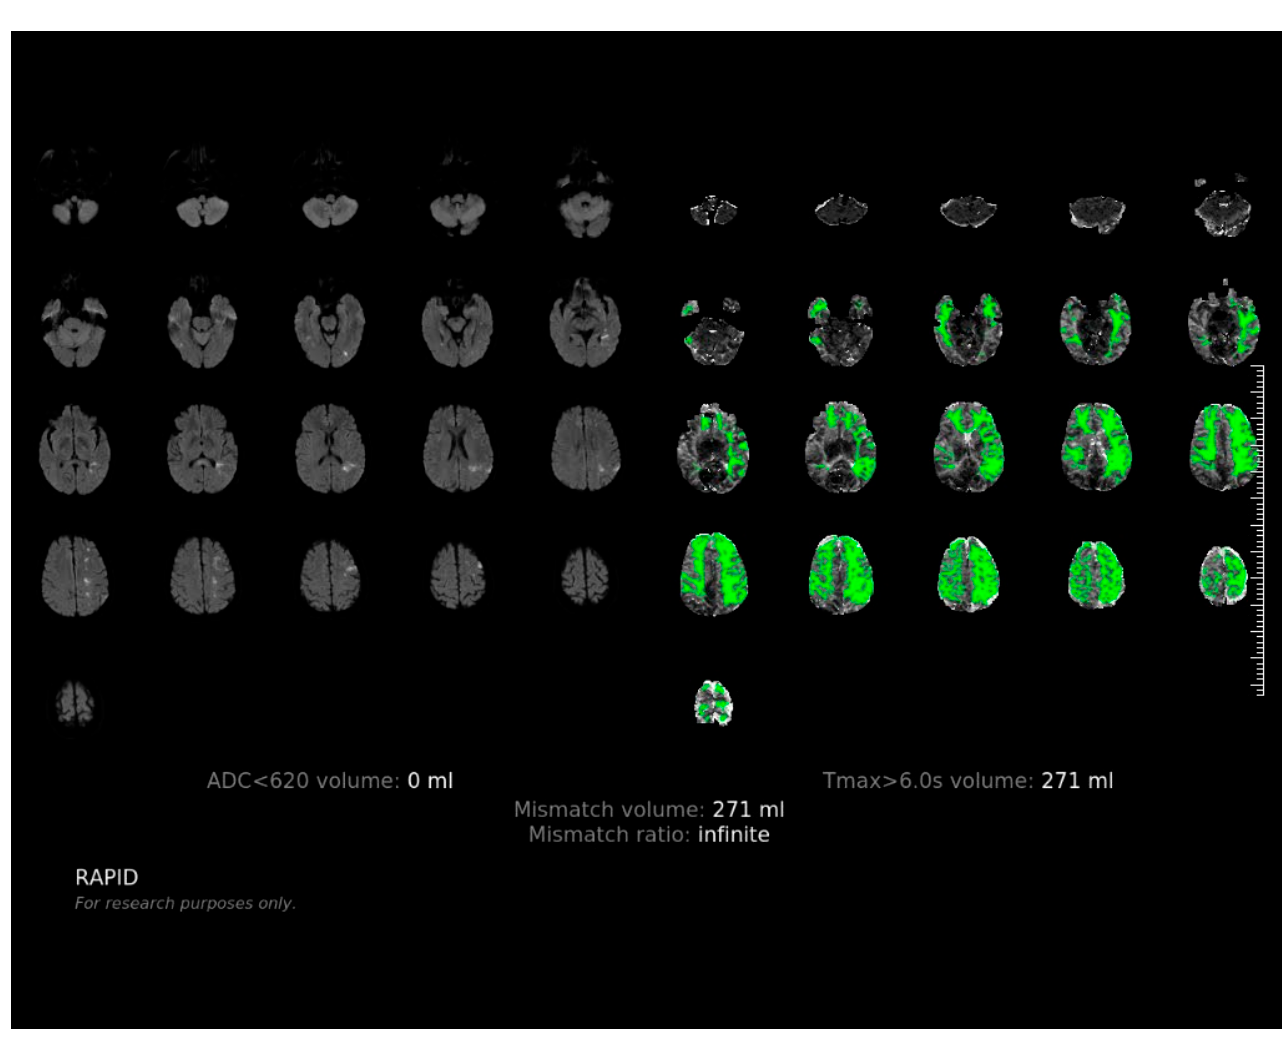
Figure A3. The calculation of the mismatch area.